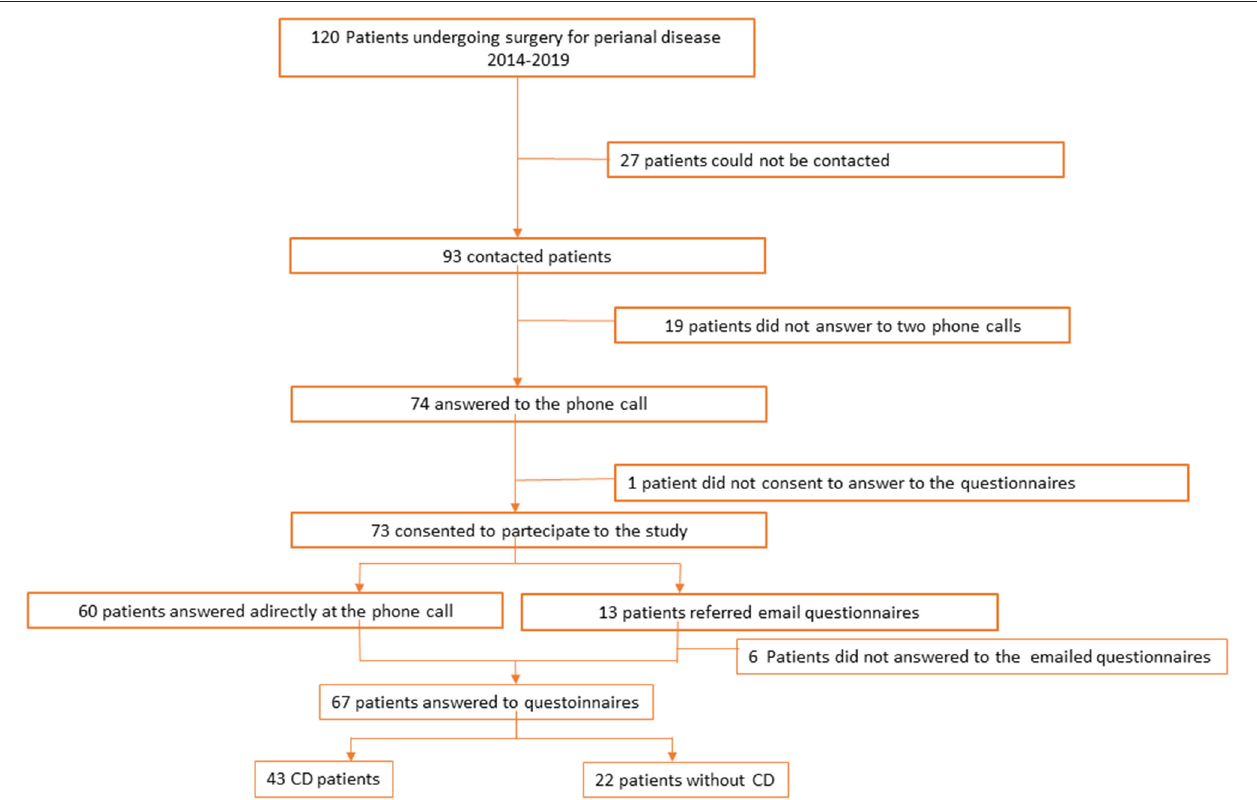
FIGURE 1 | Patients